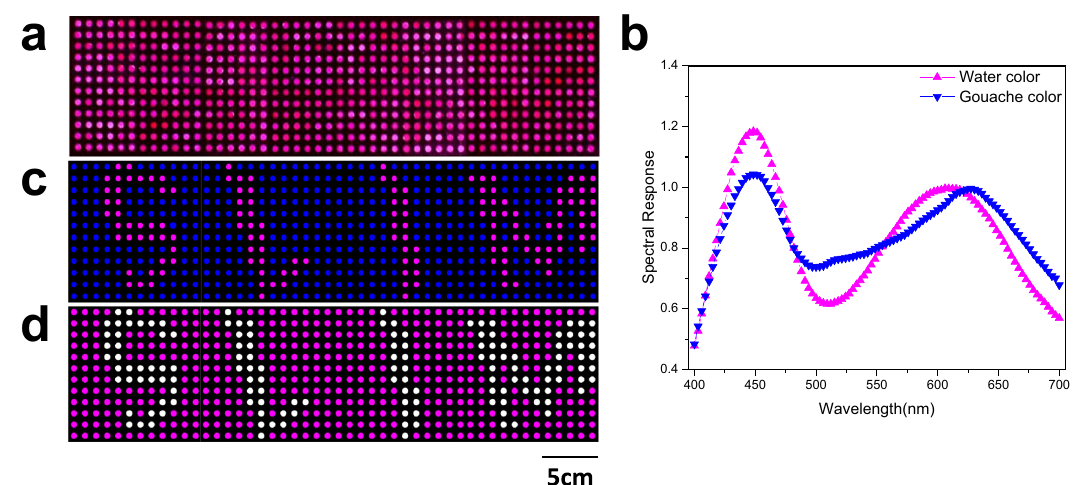
Fig. 6 Material discrimination using SLIM. a Images captured with conventional camera. b The spectral response for characters and background, respectively. c The rendered image with the SLIM system and reconstruction algorithm, the slight spectral difference can be magni fi ed, making the hidden information visible. d Pattern design of ( a